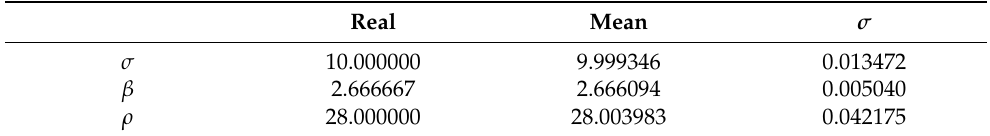
Table 3. Estimated parameters obtained using the pruned-enriching algorithm with δ variable, averaged over Ω = 50 realizations.